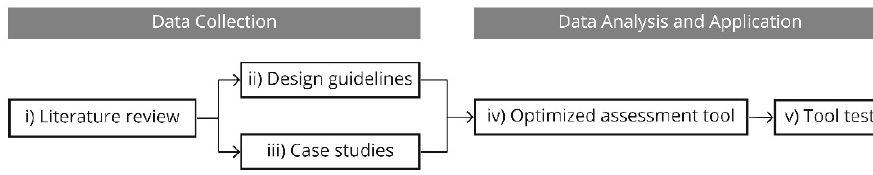
Figure 1. Flowchart profile of the research methodology